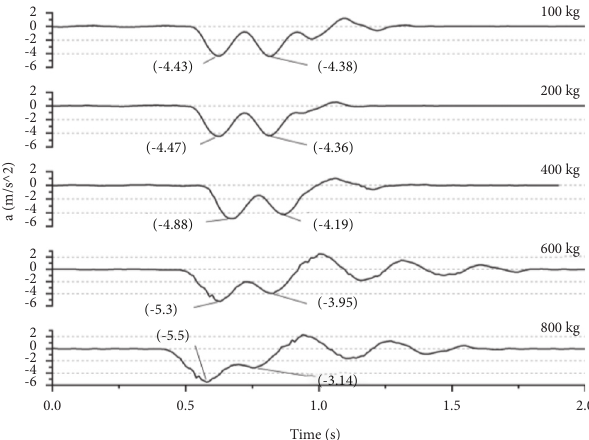
Figure 5: Longitudinal vibrations of the car during the upward emergency stop.